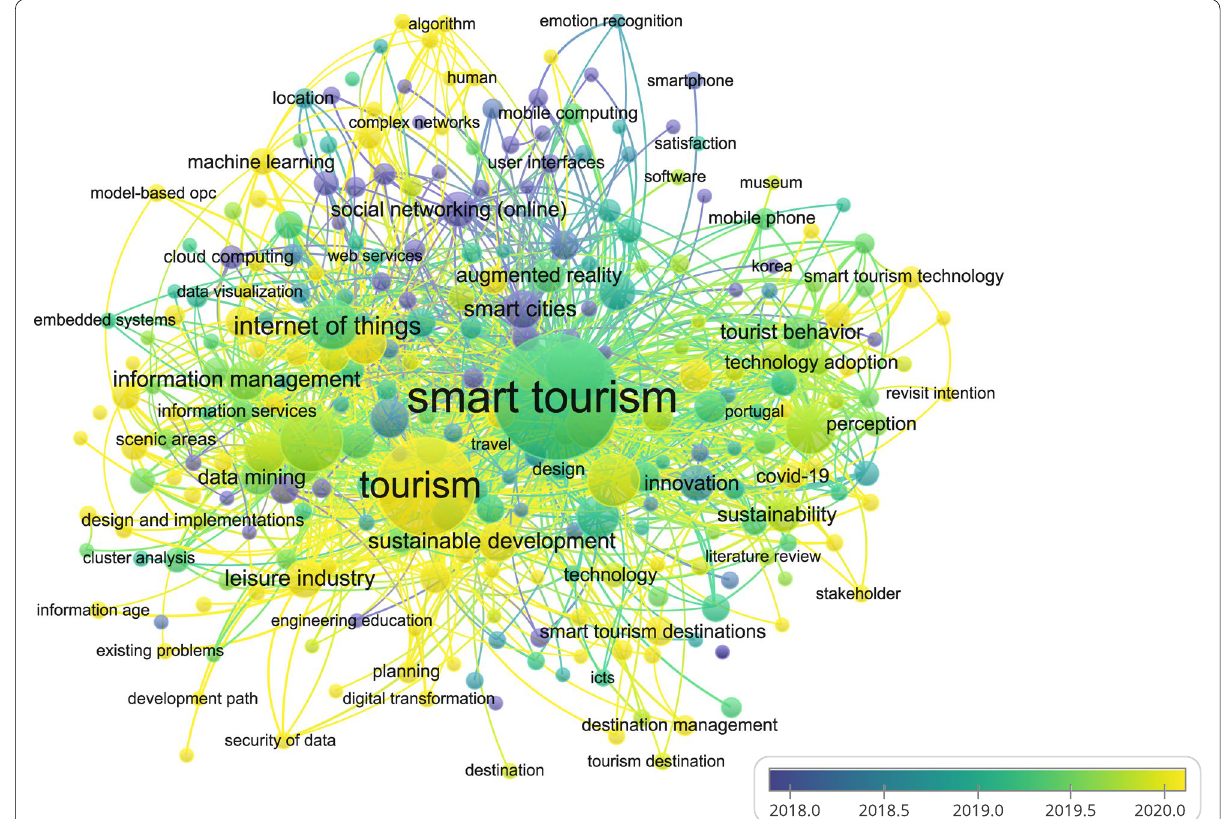
Fig. 6 Keywords: Overlay visualization